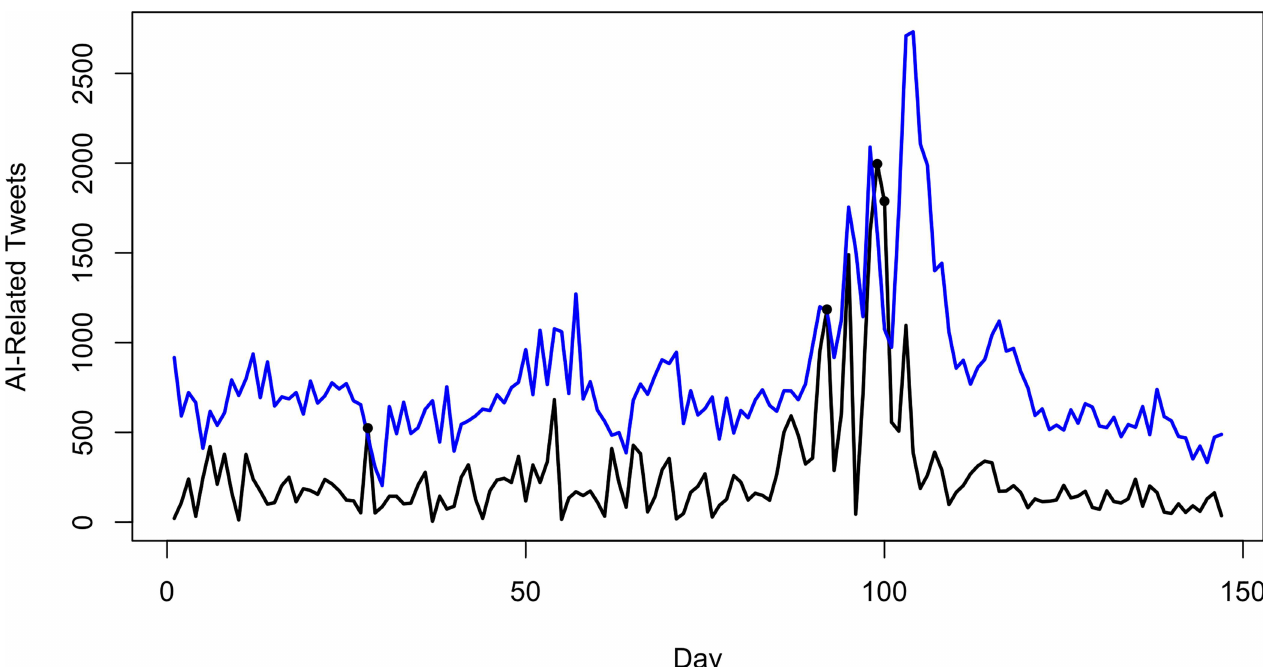
Fig 6. Observed daily time series of AI-related Twitter activity, black circles indicate significant errors (possible outbreaks) based on the dynamic threshold criterion (blue